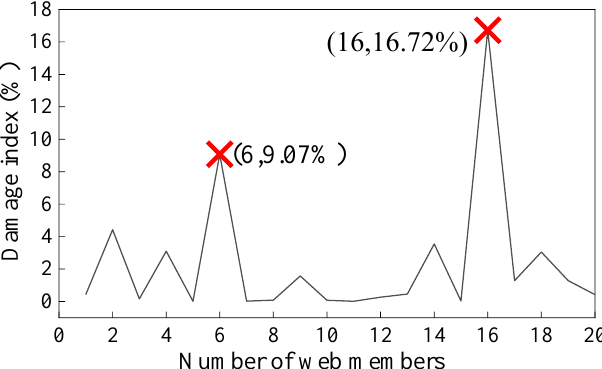
Figure 13. Stress inference results based on the vehicle loads without noise.